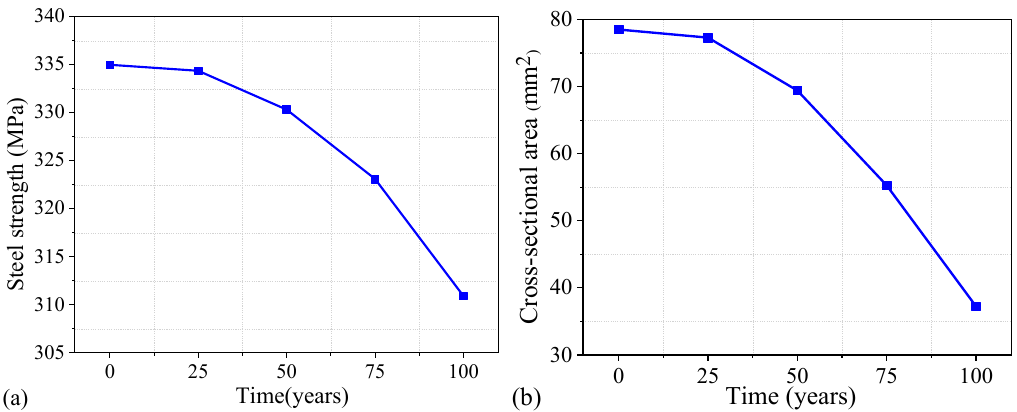
Figure 10. Time-dependent material properties of the stirrups: ( a ) yield strength and ( b ) cross-sectional area.